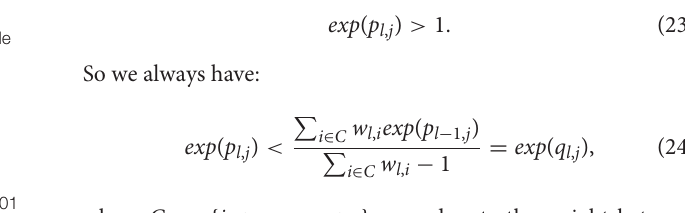
TABLE 2 | Hyperparameters for algorithms in experiments. Hyperparameter Optimization